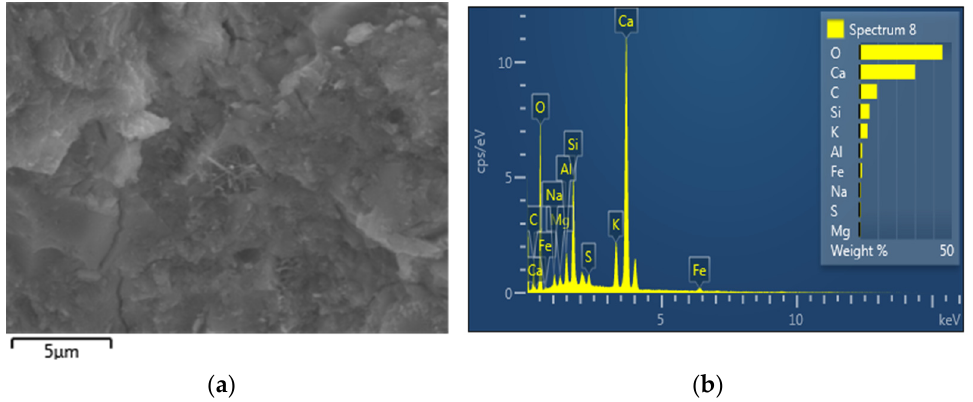
Figure 11. EDS results of cement paste containing TEOS/PVP NFs: ( a ) SEM image; ( b ) EDS spectrum.